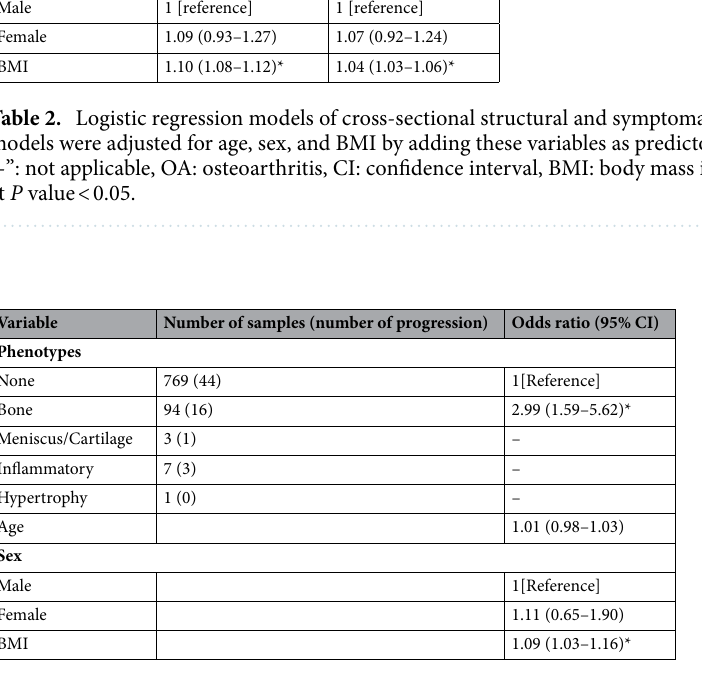
Table 3. Association between phenotypes and incidence of structural OA within 48 months from baseline among participants without OA at baseline (n = 874). Model adjusted for age, sex, and BMI.